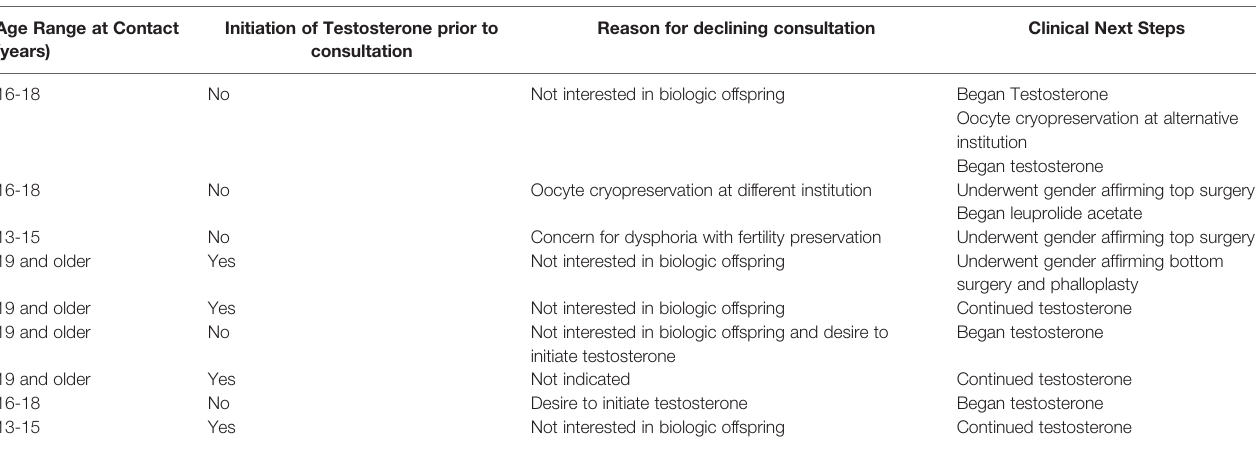
TABLE 1 | Characteristics of AYA transmen who did not seek